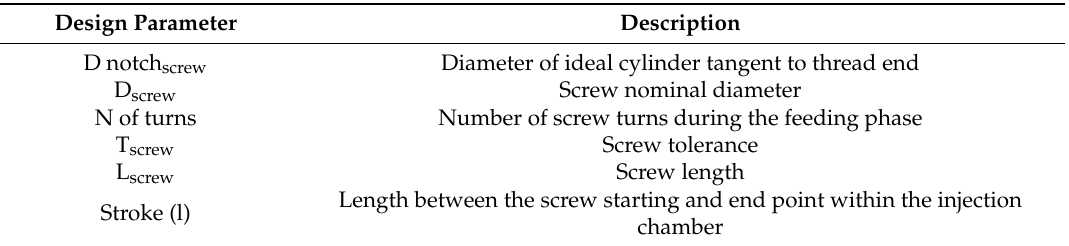
Table 6. List of design parameters of IM machine.